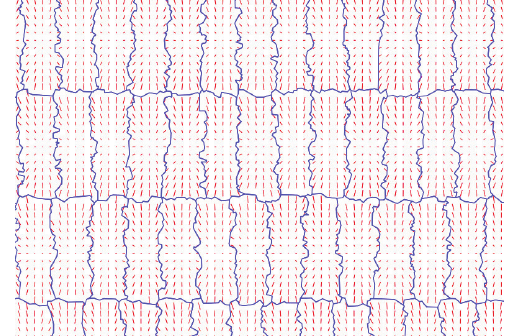
Figure 4. D / H factor’s lever